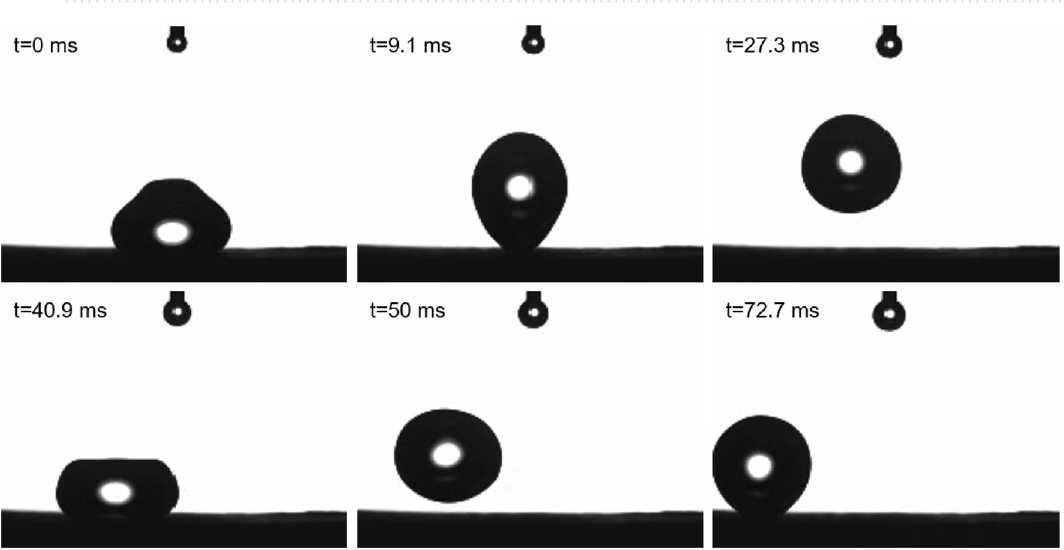
Figure 4. ( a )100 μl droplet of water was placed on a polypropylene foam sample with the rough porous surface exposed. It can be observed that the contact angle between the droplet and the foam surface is larger than 150 The white cap of the water droplet is merely the reflection of the laboratory ceiling. The instantaneous contact angles measured for droplets with volumes of: 2 μl ( b ) and 5.8 μl using the tensiometer. The needle gauge of the capillary seen above the droplet in ( b ) and ( c ) is 30 (internal diameter of 0.16 mm).